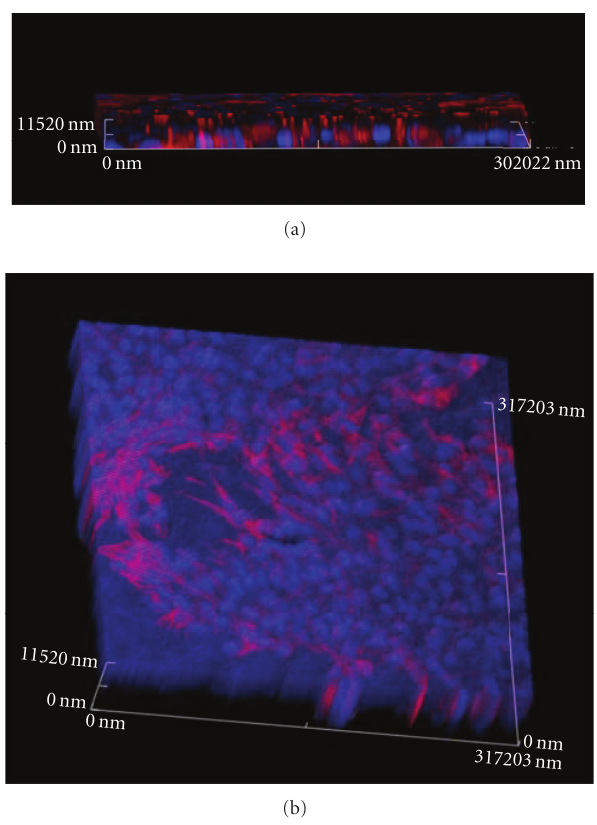
Figure 24: Growth of Vim immune fluorescent stained human corneal stromal cells in nanocellulose sca ff old, observed by LSCM (400X)